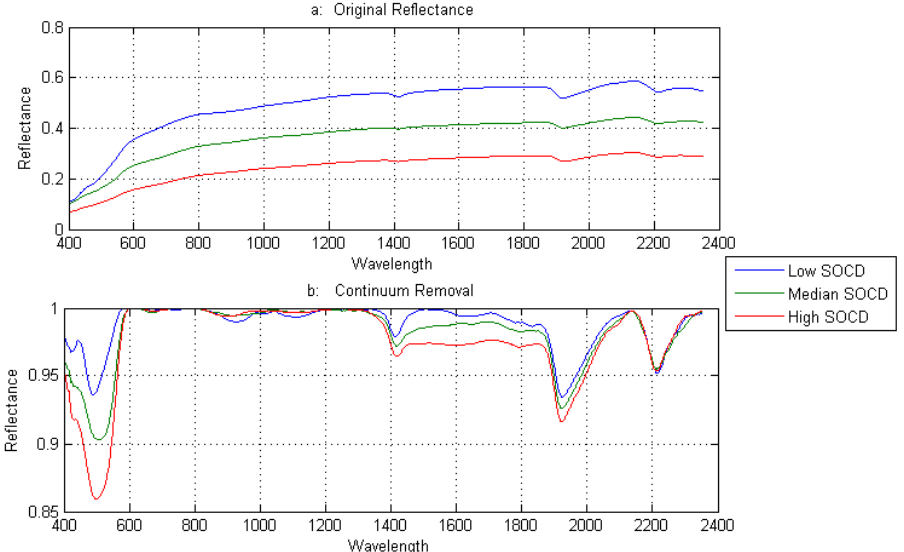
Figure 2. The original ( a ) and continuum removal responses ( b ) of the spectral reflectance of the representative soil organic carbon density contents. SOCD: soil organic carbon density, High SOCD: